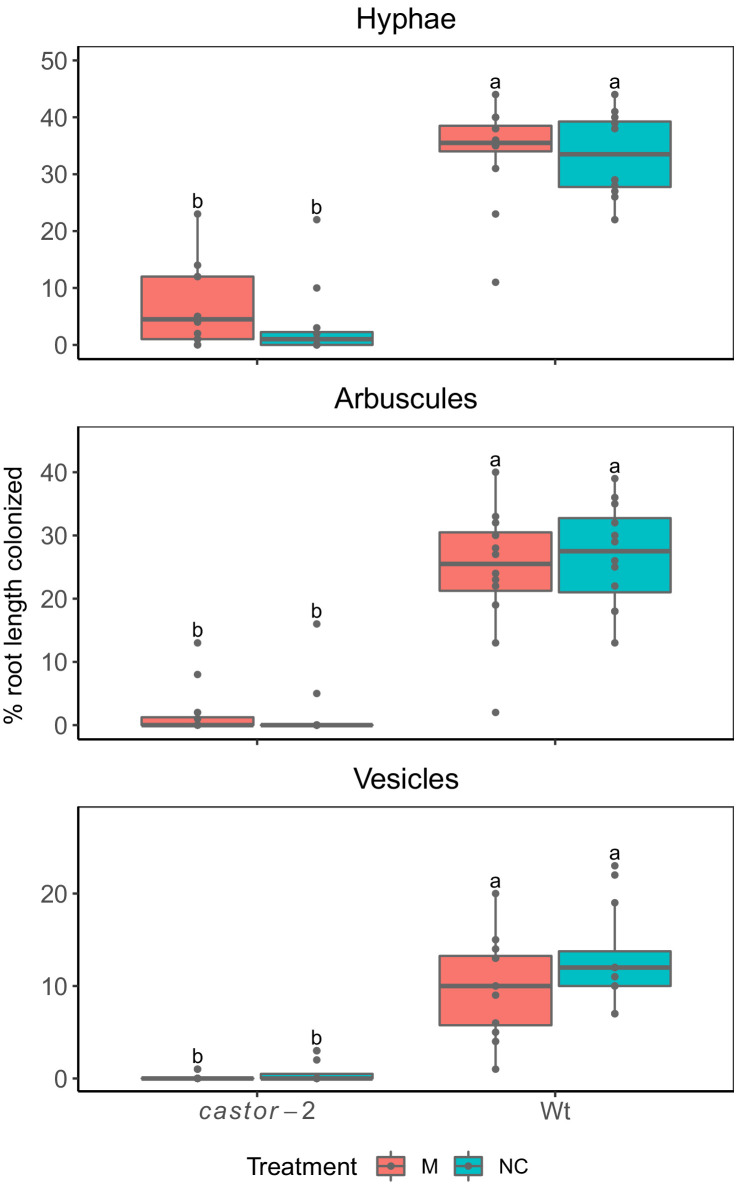
Maize castor-2 mutants are resistant to colonization by AMF.Field evaluation of castor-2 mutants, Irapuato, Mexico. Two complete blocks with four treatments were used: (1) AMF-S (wt) families without inoculation with exogenous AMF (NC), (2) AMF-R families (castor-2) without inoculation with AMF (NC), (3) AMF-S families (wt) with inoculation with AMF (M), and (4) AMF-R families (castor-2) with inoculation of AMF (M). The inoculum used was the commercial consortium BioMic which includes: Glomus constrictum, Glomus geosporum, Glomus tortuosum, Acaulospora scrobiculata, Gigaspora margarita, and Glomus sp. Field colonization of wt families without application of exogenous inoculum indicates the action of the native community of AMF.